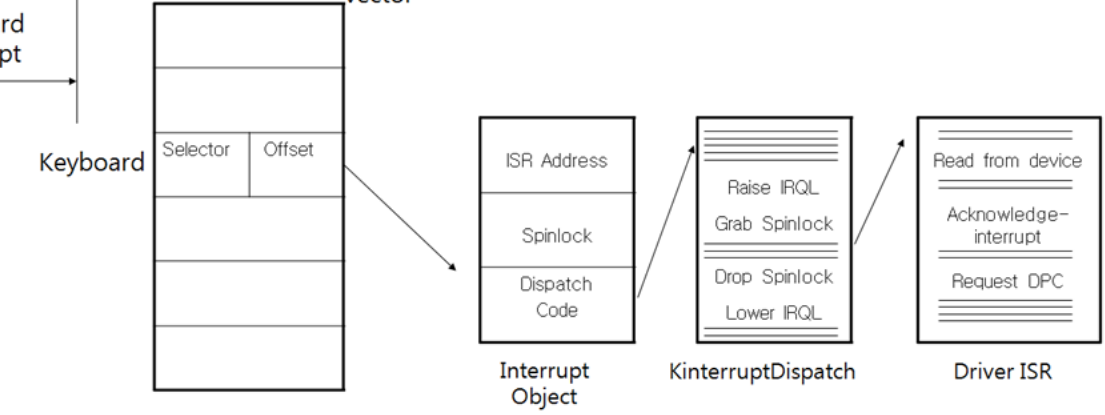
Figure 3. The calling process of the interrupt-service routine of the keyboard in the operating system.